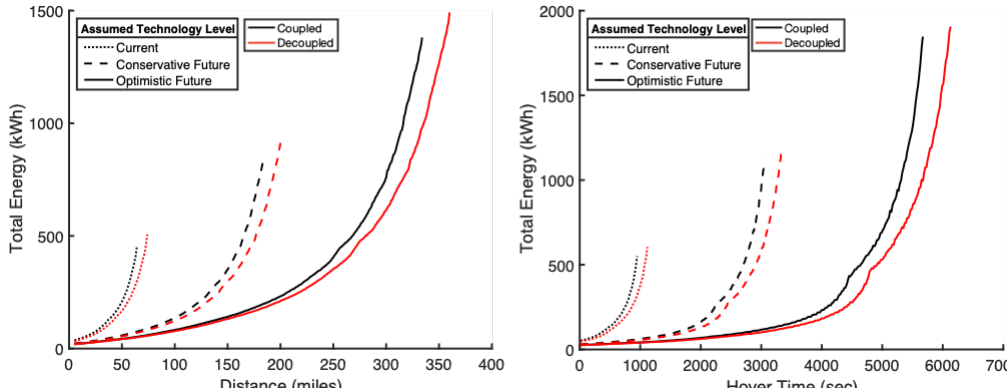
Figure 13. The lift-augmented compound helicopter total energy consumption per mission distance and hover time for the coupled and decoupled